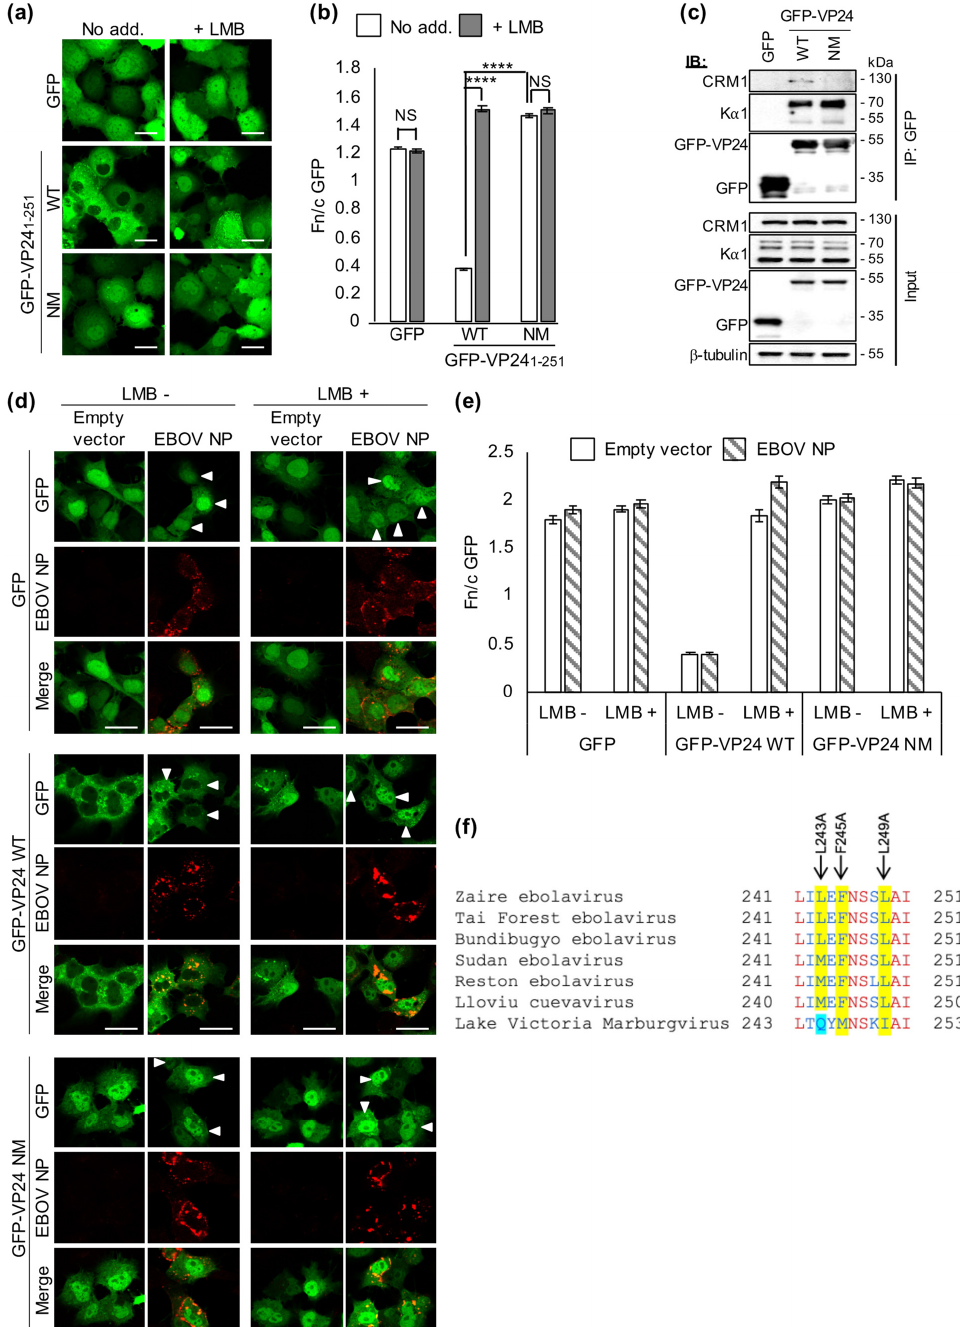
Figure 2. L243, F245 and L249 are critical for VP24 nuclear export. ( a , b ) COS7 cells transfected to express the indicated proteins were treated 24 h post-transfection with or without LMB before live-cell CLSM ( a ) to determine the Fn/c for GFP ( b ); mean ± SEM; n ≥ 50 cells; data from single assays, representative of three independent assays. ( c ) COS7 cells transfected to express the indicated proteins were lysed 24 h post-transfection before immunoprecipitation for GFP. Lysates (input) and immunoprecipitates (IP) were analyzed by immunoblotting (IB) using antibodies against the indicated proteins. Results are representative of two independent assays. ( d , e ) COS7 cells co-transfected to express the indicated proteins were treated with or without LMB before fixation, immunofluorescent staining for NP (red) and CLSM ( d ) to determine the Fn/c for GFP ( e ); mean ± SEM, n ≥ 31 cells. Arrowheads indicate cells with detectable NP expression. ( f ) Alignment of the C-terminal 11 residues of VP24. Red and blue font indicate conserved and non-conserved residues, respectively; EBOV VP24 residues implicated in CRM1-dependent nuclear export highlighted in yellow; Q245 of MARV VP24 highlighted in blue. ****, p < 0.0001; NS, not significant; No add., no addition; WT, wildtype; NM, NES mutant. Scale bars, 30 µ